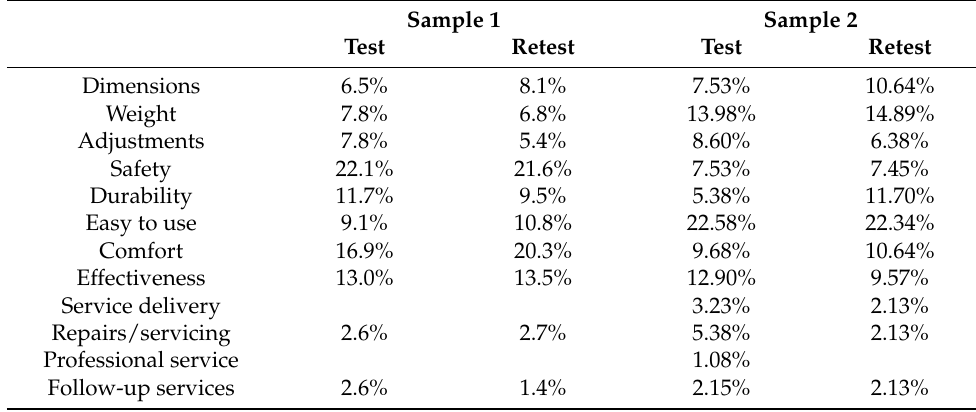
Table 3. QUEST 2.0-ES item satisfaction percentage distribution.